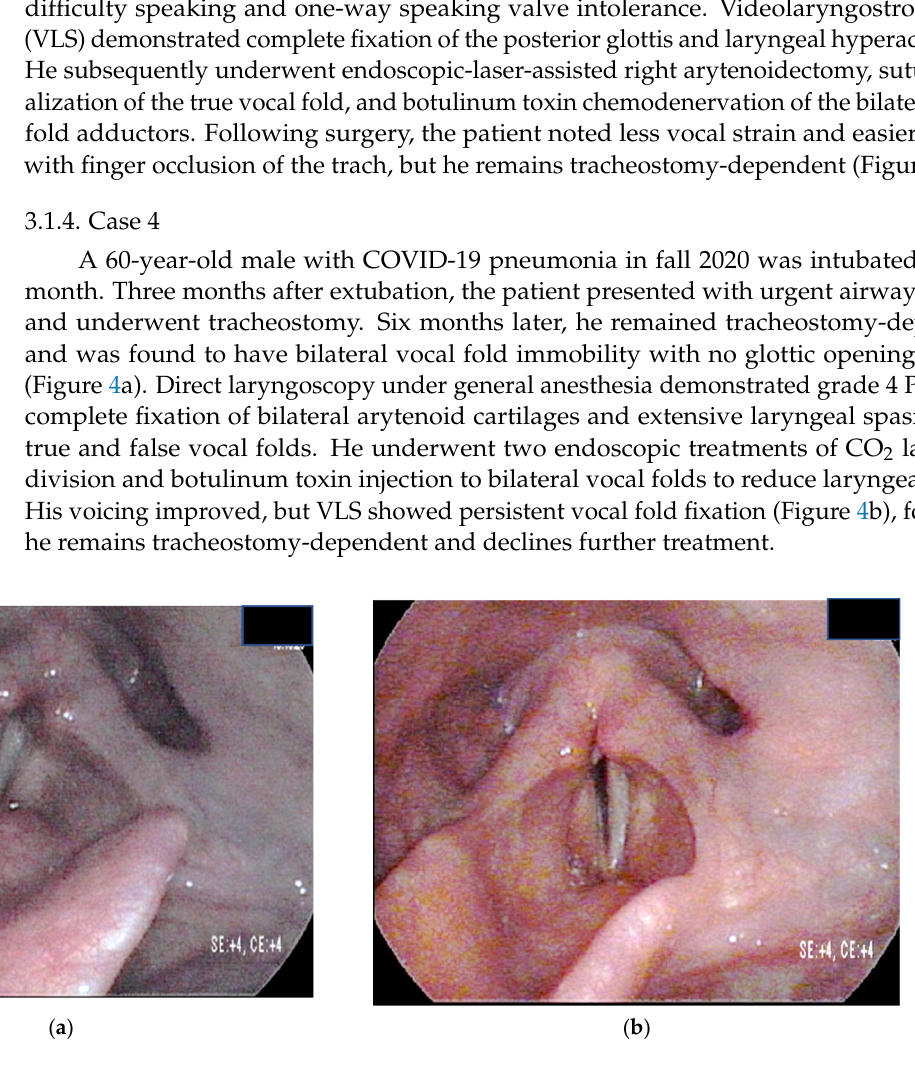
and easier voicing with finger occlusion of the trach, but he remains tracheostomy-de- pendent (Figure 3b).